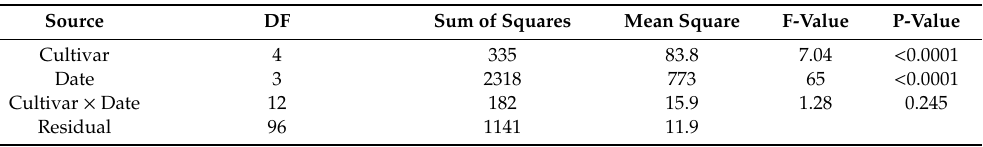
Table 2. Analysis of variance for measurements of WUE i of five soybean cultivars measured on four dates in Figure 3. Relationships between mean intrinsic leaf water-use efficiency (WUE i ) and corrected isotope delta values for 13 C (CID) among five cultivars of soybeans in 2017 and 2018. Correlations between WUE i and CID were non-significant at P = 0.05 in either year. See text for details.